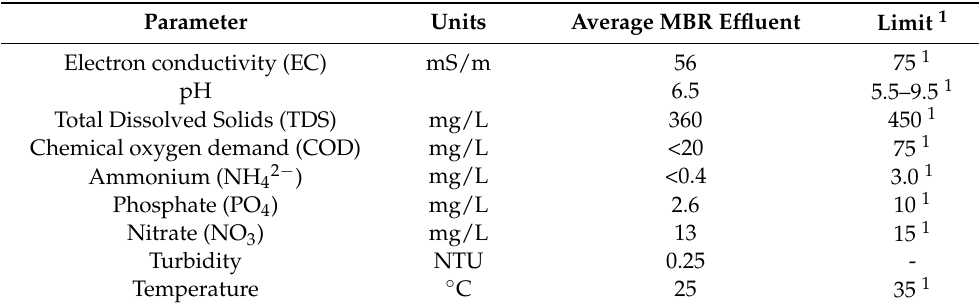
Table 1. Pilot plant operating conditions [8]. Table 2. The physicochemical characteristics of the membrane bioreactor (MBR) effluent.